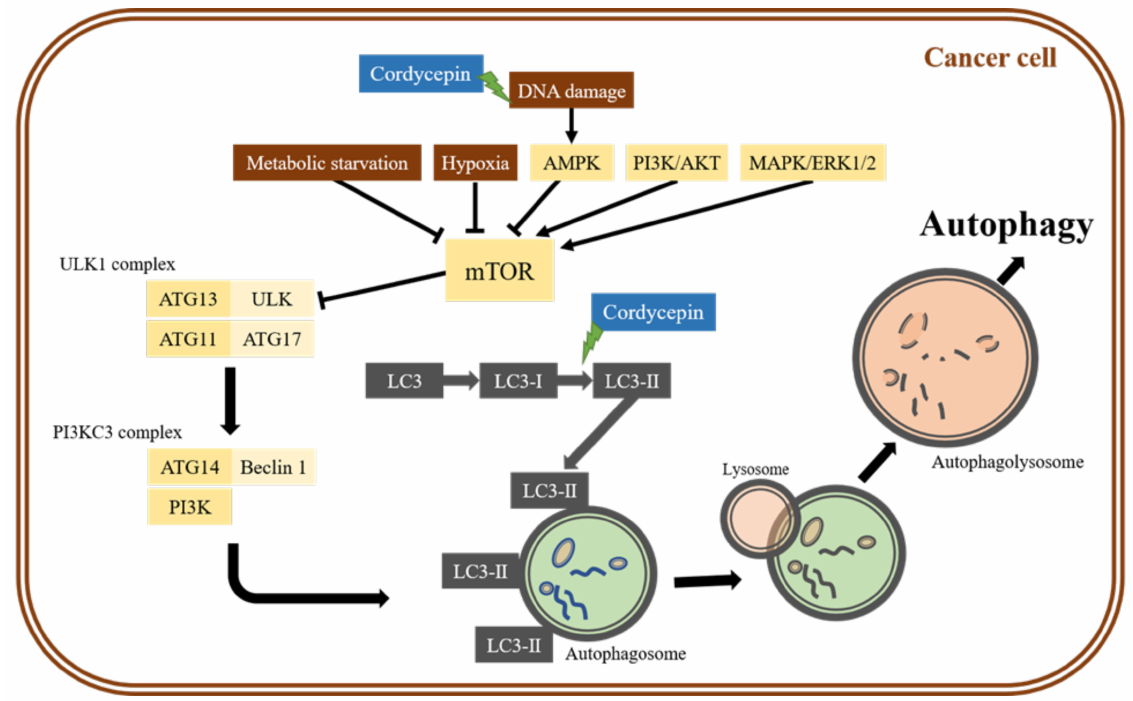
Figure 1. The anti-cancer mechanisms of cordycepin-induced autophagy. Various stress conditions, such as metabolic starvation, hypoxia, and DNA damage, initiate the autophagic process. Stress conditions inhibit mechanistic target of rapamycin (mTOR), leading to the activation of Unc-51-like kinase 1 (ULK1) complex, which triggers the formation of the phagophore by activating the “initiation complex”. Cordycepin could cause DNA damage and trigger the inhibition of the mTOR pathway to induce cancer cell death. The phosphatidylethanolamine-conjugated form of Microtubule-associated protein 1A/1B-light chain 3-II (LC3-II), which is converted from LC3-I by ATG 4-dependent cleavage, is critically involved in the fusion of mature autophagosomes and lysosomes. The autophagolysosome, which is already fused with a lysosome, could then result in the degradation and recycling of metabolites. Cordycepin also upregulates LC3-II expression, leading to autophagy in cancer